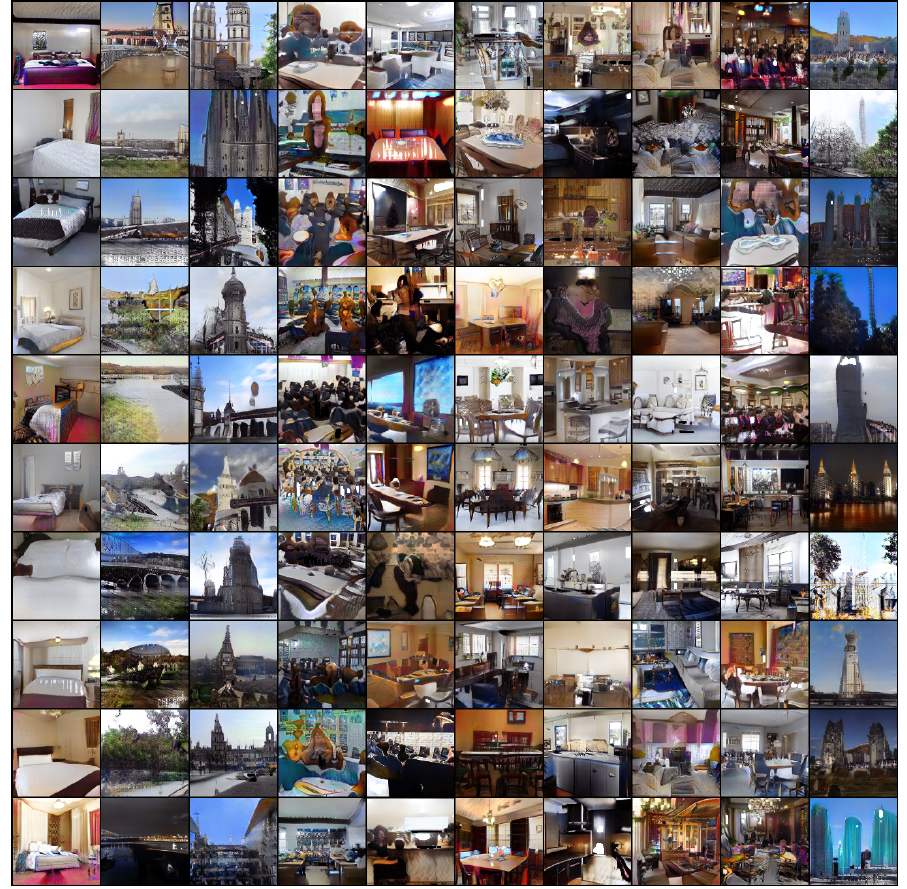
Figure 5. Random examples of the generated images by ScoreGAN with the LSUN dataset. The im- ages are a 128 × 128 resolution. Each column represents each class in the LSUN dataset, i.e.,